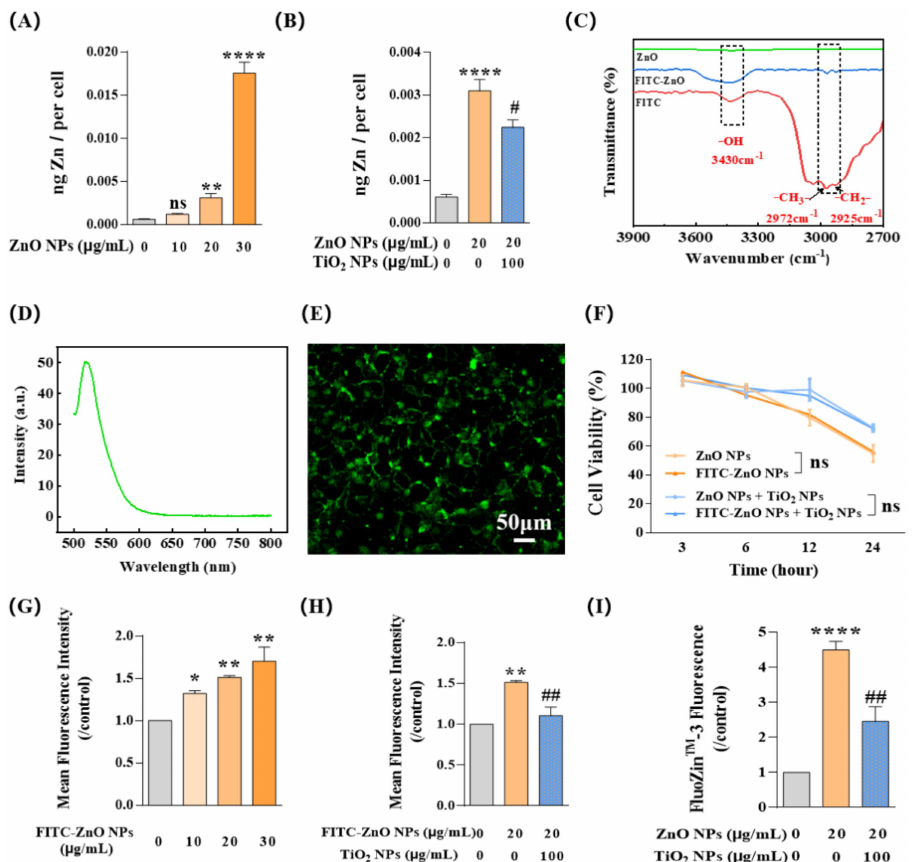
Figure 4. TiO 2 NPs reduced the intracellular content of both ZnO NPs and Zn 2+ ions. ( A , B ) Intracel- lular Zn content was measured by flame atomic absorption spectroscopy (AAS) at different doses of ZnO NPs (0, 10, 20, and 30 µ g/mL) with ( B ) or without ( A ) TiO 2 NPs. ( C ) Fourier transform infrared spectrometer (FT-IR) measurements proved that FITC had been successfully introduced to the surface of ZnO NPs. ( D ) Emission spectra of FITC-ZnO NPs confirmed that FITC was successfully loaded onto particles. ( E ) FITC-ZnO NPs showed green fluorescence at the excitation wavelength of 488 nm when incubated with HaCaT cells. ( F ) FITC-ZnO NPs showed no difference in cytotoxicity compared to ZnO NPs without loading of FITC. ( G , H ) The cellular uptake of FITC-ZnO NPs with ( H ) or without ( G ) TiO 2 NPs was investigated by flow cytometry (FCM). ( I ) The intracellular Zn 2+ ions indicated by FluoZin-3, a Zn 2+ specific probe, were investigated by FCM. * p < 0.05, ** p < 0.01, **** p < 0.0001 compared to the control group. # p < 0.05, ## p < 0.01 compared to ZnO NP-treated